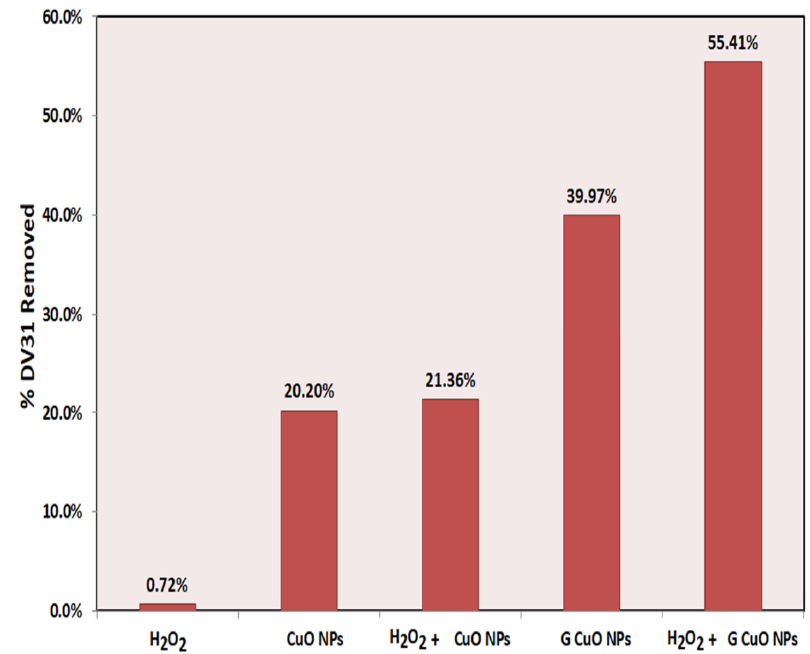
Figure 5. Selection of the suitable CuO NPs for the removal DV31 dye from aqueous solution. (Experimental conditions: DV31 dye concentration 25 mg/L; sample volume 100 mL; 10.0 mg CuO NPs; 1 mL H 2 O 2 ; 30 min contact time; pH 8.6 and temperature at 25 °C).